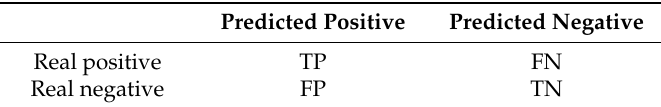
Table 3. Confusion